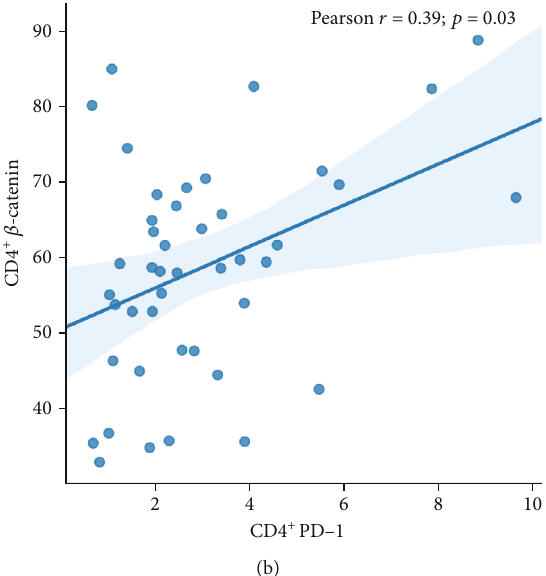
Figure 6: (a) The correlation of β -catenin, PD-1, and IFN- γ on CD4 T cells. (b) The correlation of β -catenin and PD-1 on CD4 T cells ( n = 47